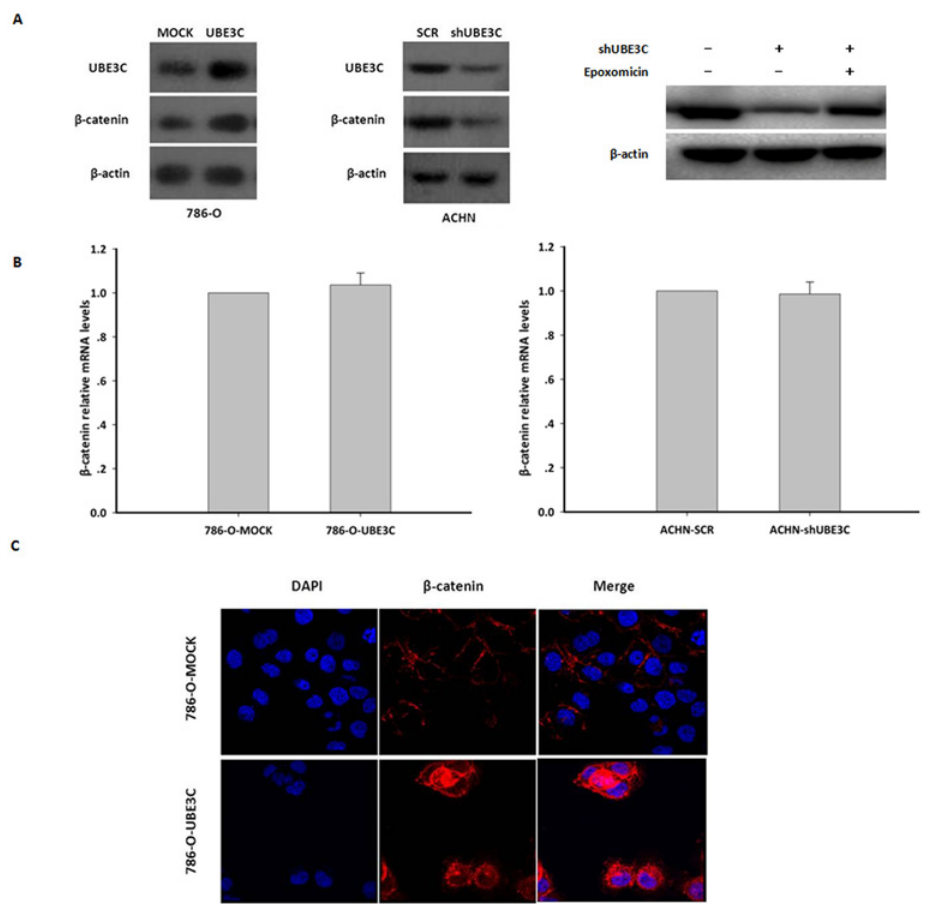
Figure 3. UBE3C up-regulates β -catenin expression and promotes the nuclear accumulation of β - catenin. (A) Overexpression of UBE3C in 786-O cells increased β -catenin expression (left). But, knockdown of UBE3C expression in ACHN cells reduced β -catenin expression (middle). β -catenin degradation induced by UBE3C knockdown was substantially attenuated when the cells were treated with epoxomicin (right). (B) Overexpression of UBE3C in 786-O cell did not change β -catenin mRNA expression. Knockdown of UBE3C expression also did not induce β -catenin mRNA levels. β -catenin mRNA was measured using qrtPCR. Means (cid:1) SD from three independent experiments were presented as relative ratio to the control whose value was taken as 1.0. (C) Immunofluorescence assay revealed that exogenous expression of UBE3C indeed promotes β -catenin translocation to the nucleus in 786-O cells.